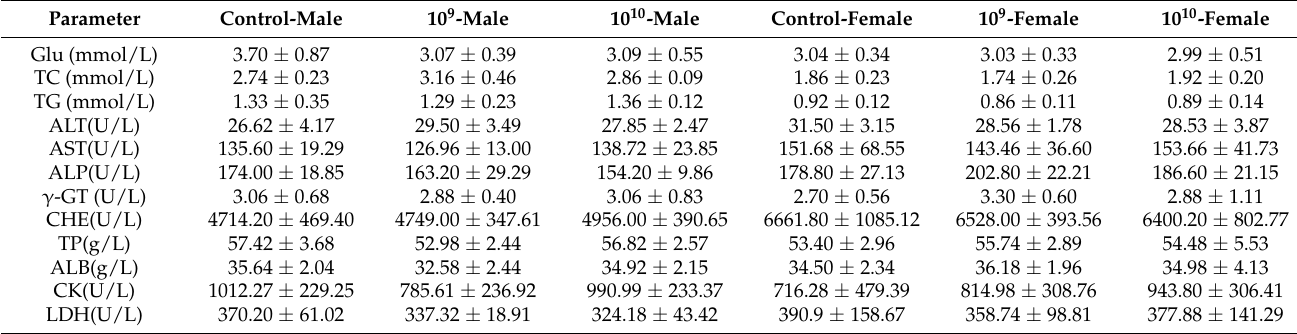
Table 5. Effect of Blautia producta DSM 2950 on serum biochemical